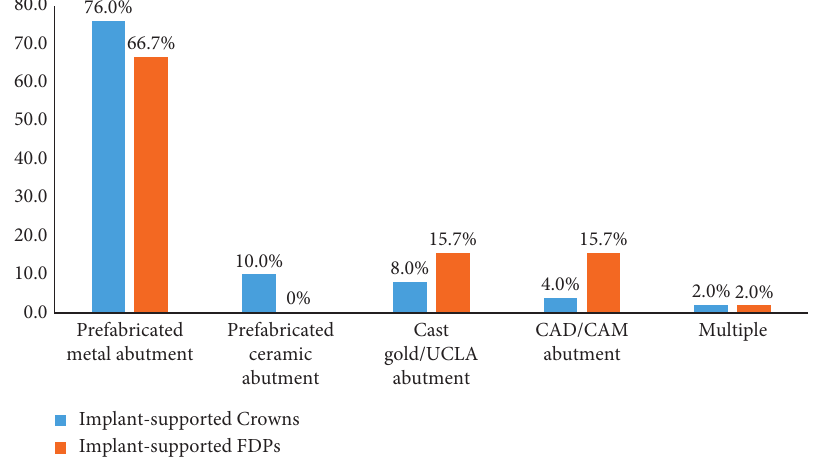
Figure 1: The types of crowns and fixed dental prostheses (FDPs) abutments.